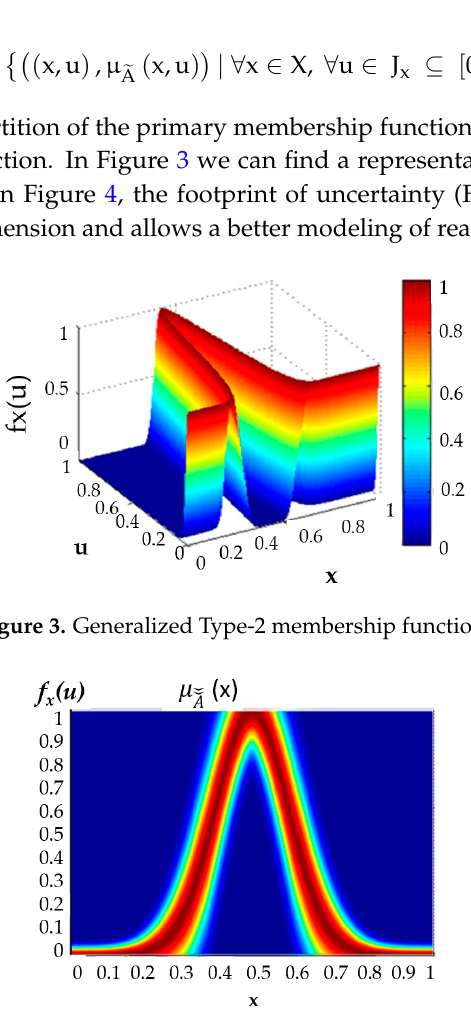
Figure 4. FOU of the Generalized Type-2 membership function.